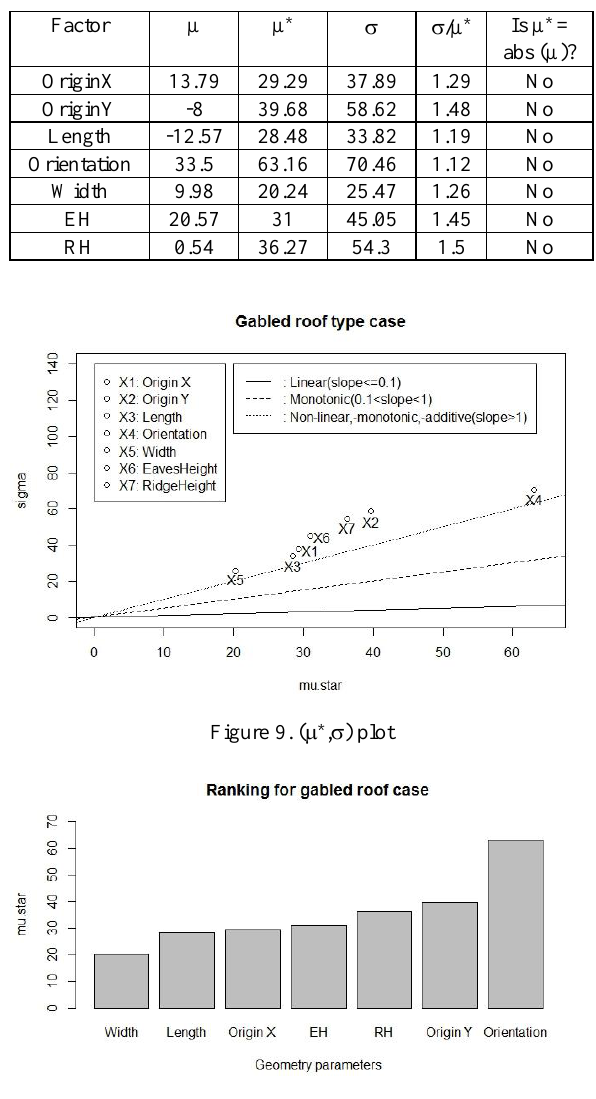
Figure 10. Ranking of influential